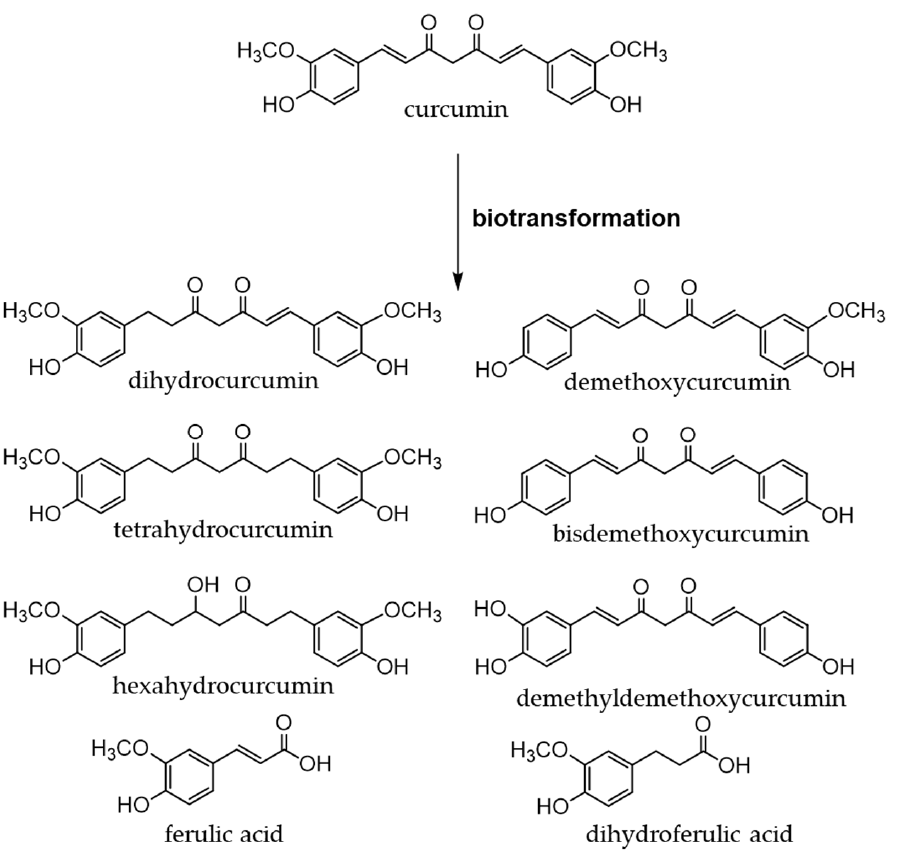
Figure 16. Biotransformation of curcumin.